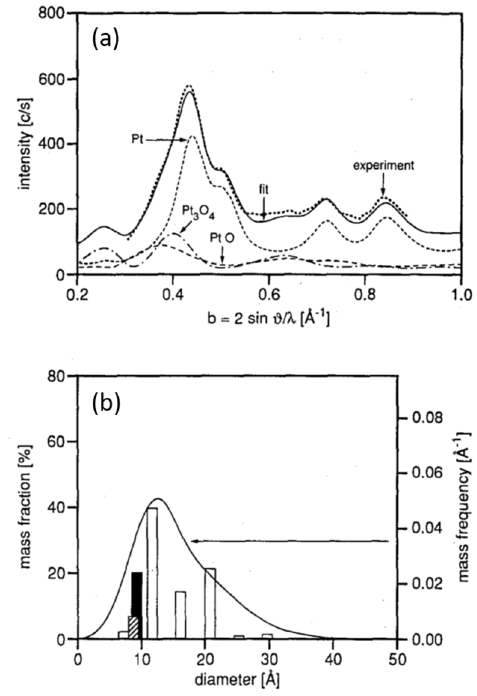
Figure 2. ( a ) The intensity profile of the Pt(111) Bragg reflection measured at point (B) in Figure 1b and showing that a reasonable fit (solid line) to the reflection requires the use of components due to oxidized phases of Pt. ( b ) The cluster size distribution use to derive the fit shown in ( a ) giving the mass fraction of the respective components used: fcc Pt nanoparticles (open bars) PtO (solid black), Pt 3 O 4 (dashed bar). Reproduced with permission from Catal. Letts. 1994 , 28 , 373–381 [92]. Copyright 1994, Springer International Publishing AG.